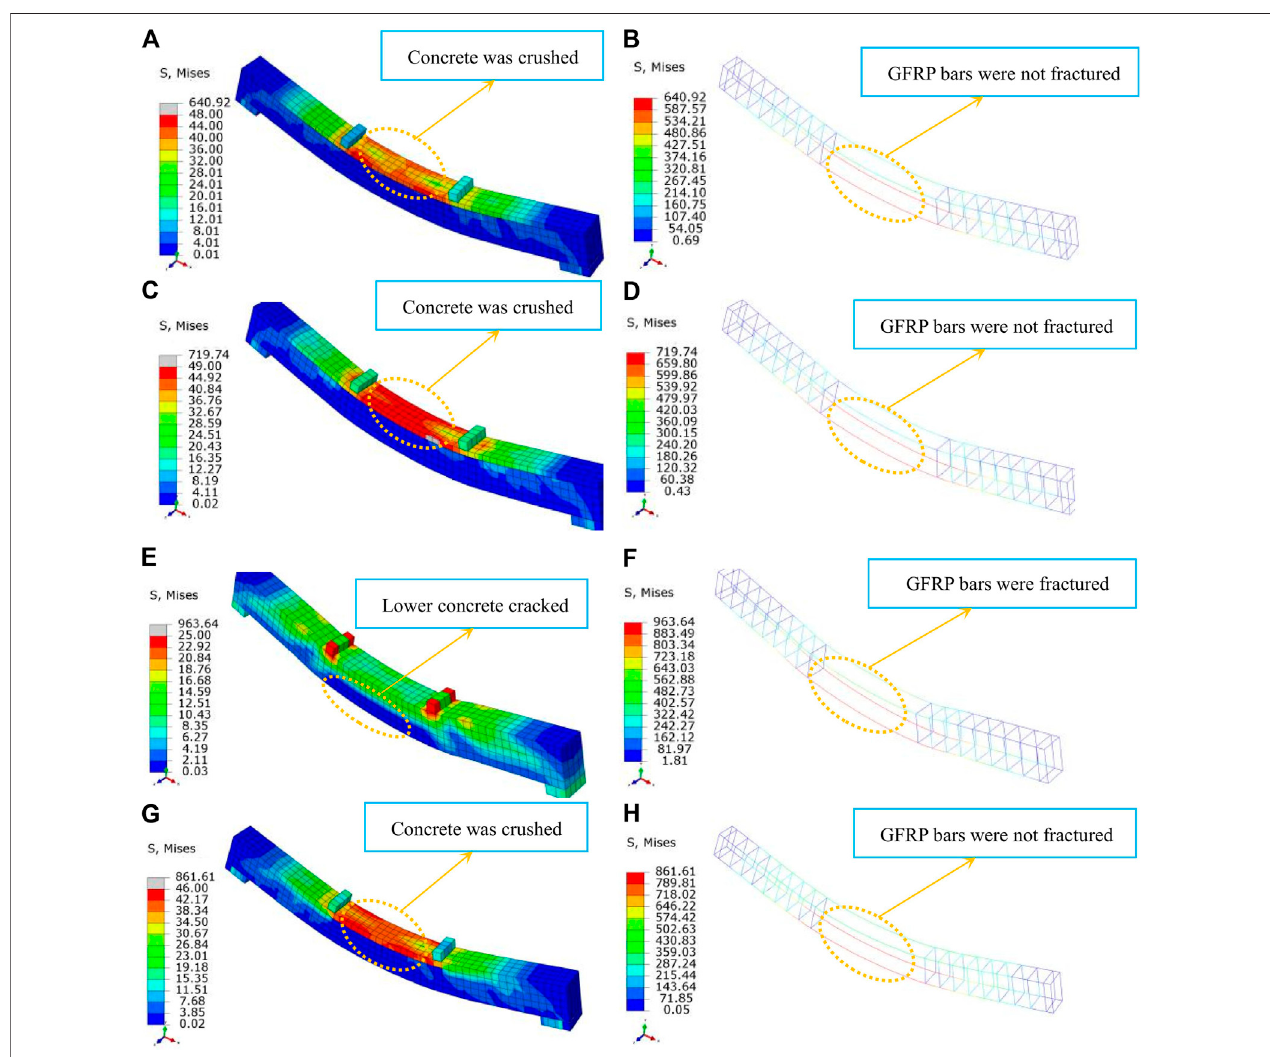
FIGURE14| Stressclouddiagrams ofspecimens: (A) stressclouddiagramofconcreteforspecimenI-1; (B) stressclouddiagramofGFRPbarsforspecimenI-1; (C) stressclouddiagramofconcreteforspecimenII-1; (D) stressclouddiagramofGFRPbarsforspecimenII-1; (E) stressclouddiagramofconcreteforspecimenPT-I- 1; (F) stress cloud diagram of GFRP bars for specimen PT-I-1; (G) stress cloud diagram of concrete for specimen GQ-I-1; (H) stress cloud diagram of GFRP bars for specimen